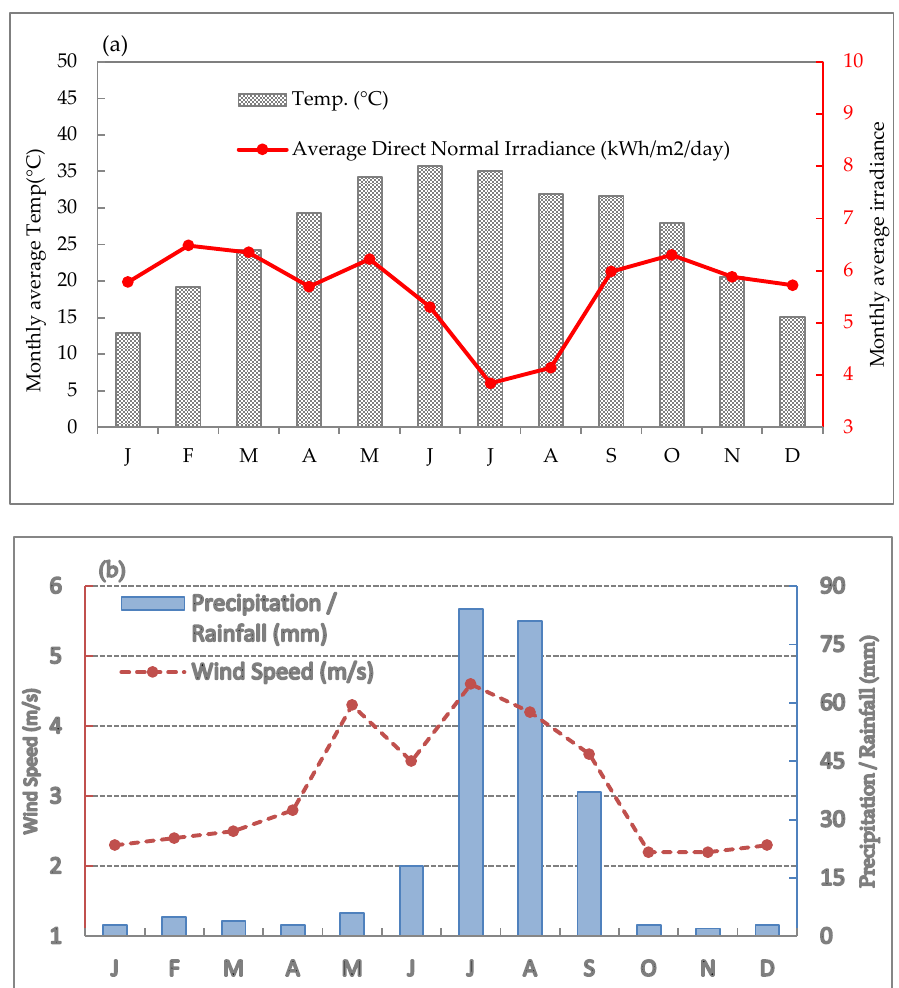
Figure 3. Monthly average climatology bar graph for Bhadla region of Rajasthan. ( a ) monthly average temperature (bar graph) and irradiance (thick line); and ( b ) graph showing monthly average wind speed (dashed line) and rainfall values (bar graph). Data source: [33,34].